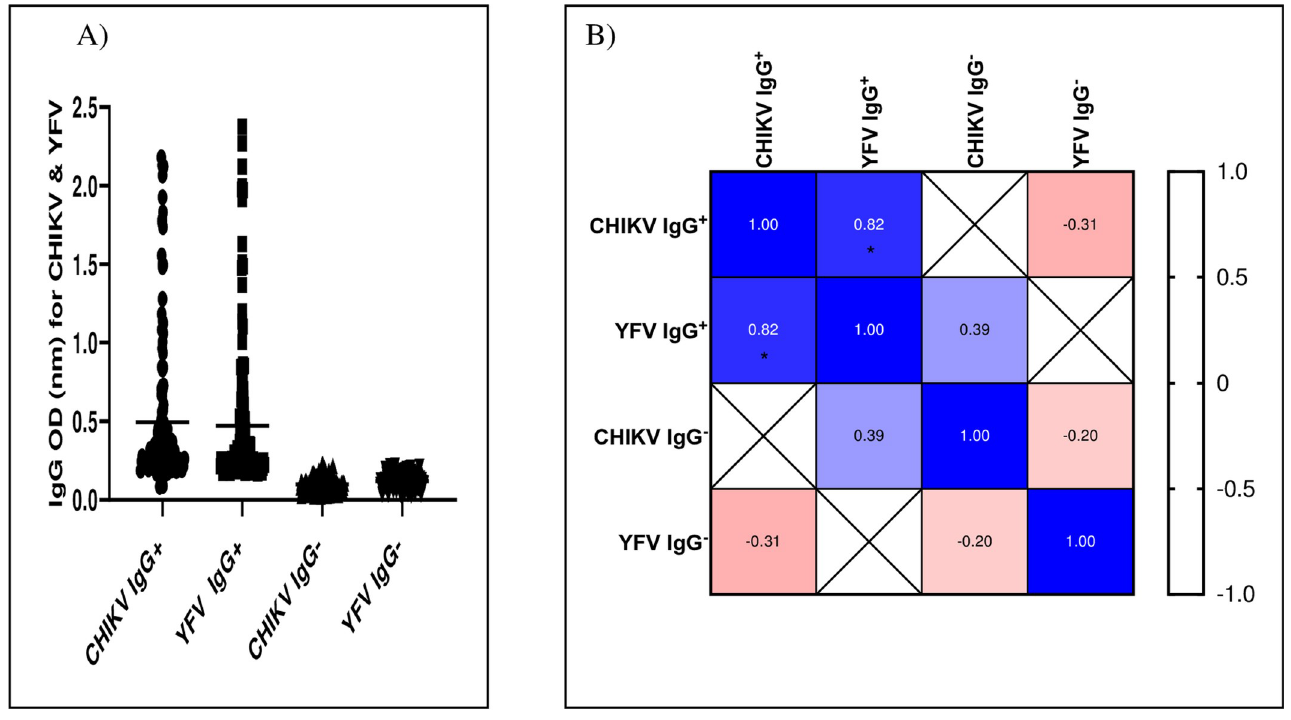
Fig 4. A & B . Correlation of IgG antibody to CHIKV with IgG antibody to YFV among the study participants.